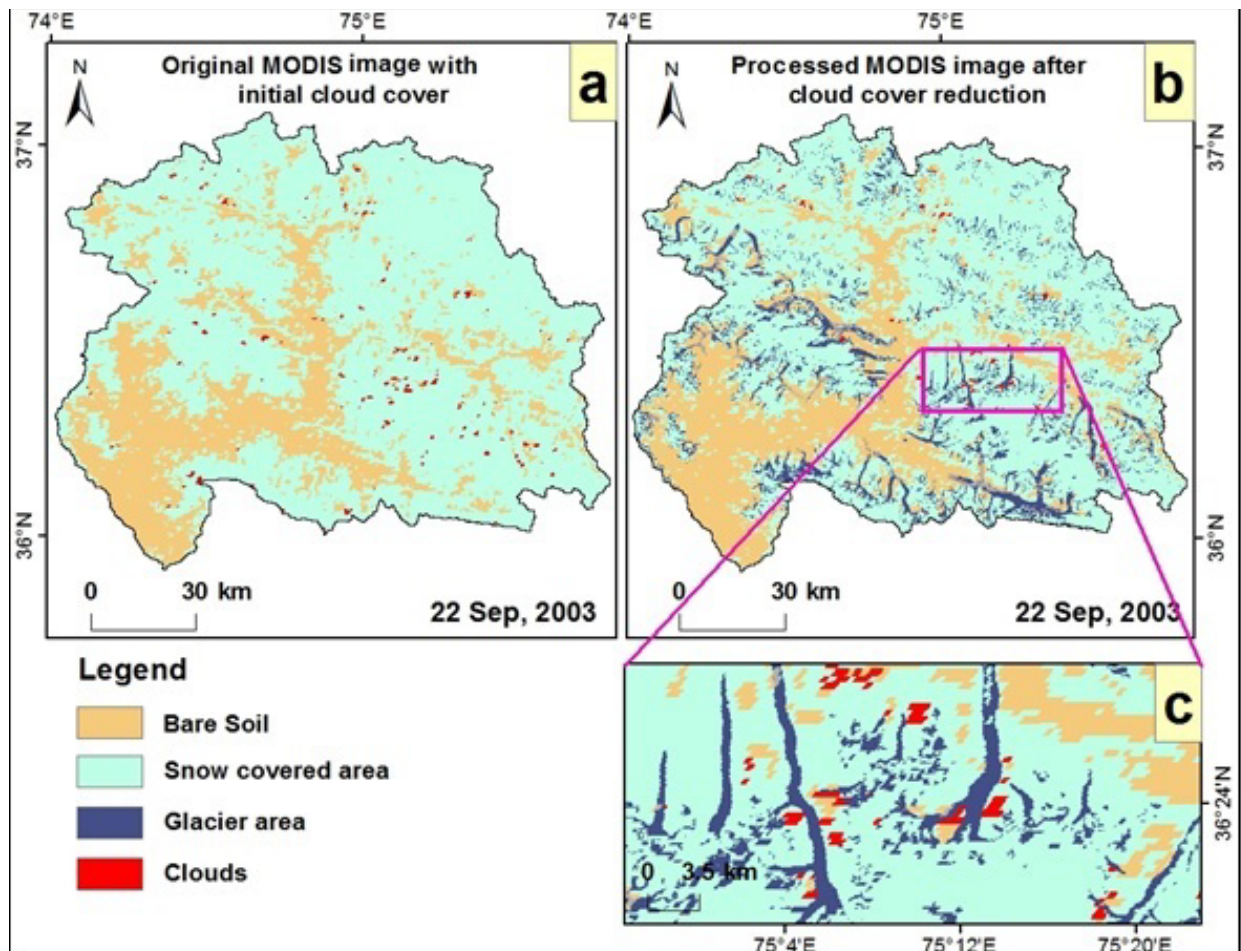
Figure 4. MODIS image of 22 September 2003. ( a ) shows the original cloud coverage in that particular image. ( b ) shows the processed MODIS of same date after reduction in cloud cover. In ( c ) it is clearly visible that clouds are removed over the glacier area.